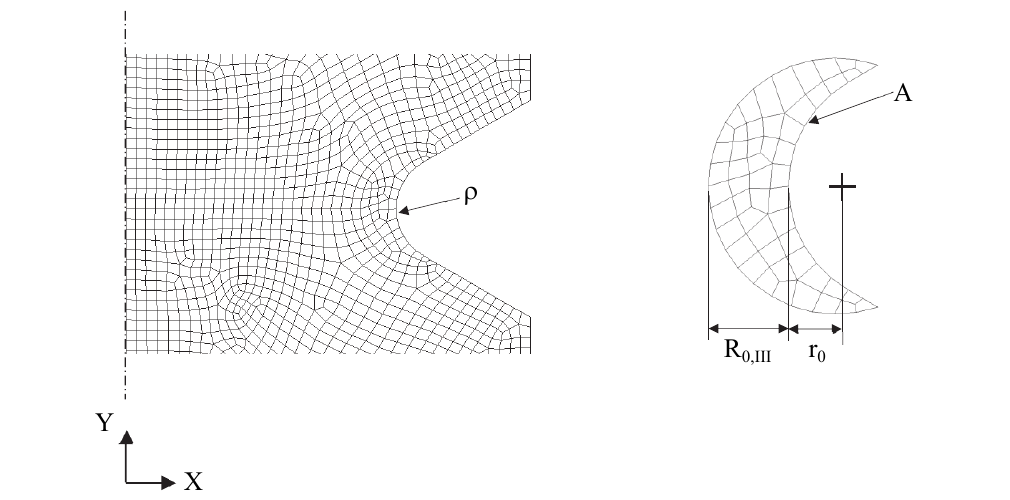
Figure 4: (a) Coarse FE mesh (about 50 FE inside the control volume) adopted in the numerical analyses producing a reduced error of 1%. The Y-axis coincides with the axis of the specimen. (b) Details of the FE mesh inside the control volume. Considered case: NB specimen made of SGV 410 steel, with  = 1.07 mm, R 0,III = 0.716 mm, r 0 = 0.428